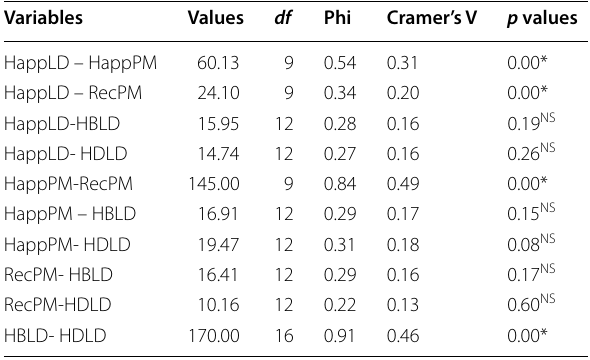
Table 4 Association between happy with lockdown, happy with palliative measure, receive palliative measure, health before and during COVID-19